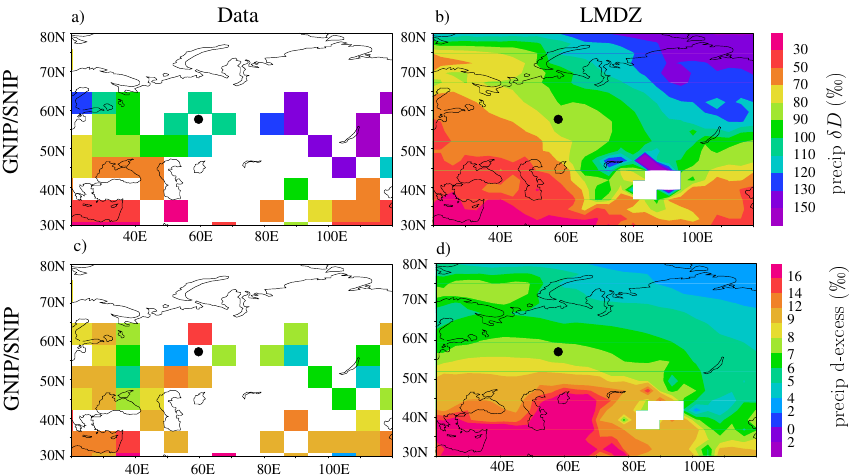
Figure 3. Annual mean maps of observed (left) and simulated (right) δD in the surface precipitation (a–b) and d excess in the surface precipitation (c–d) . The black dot indicates the location of Kourovka.